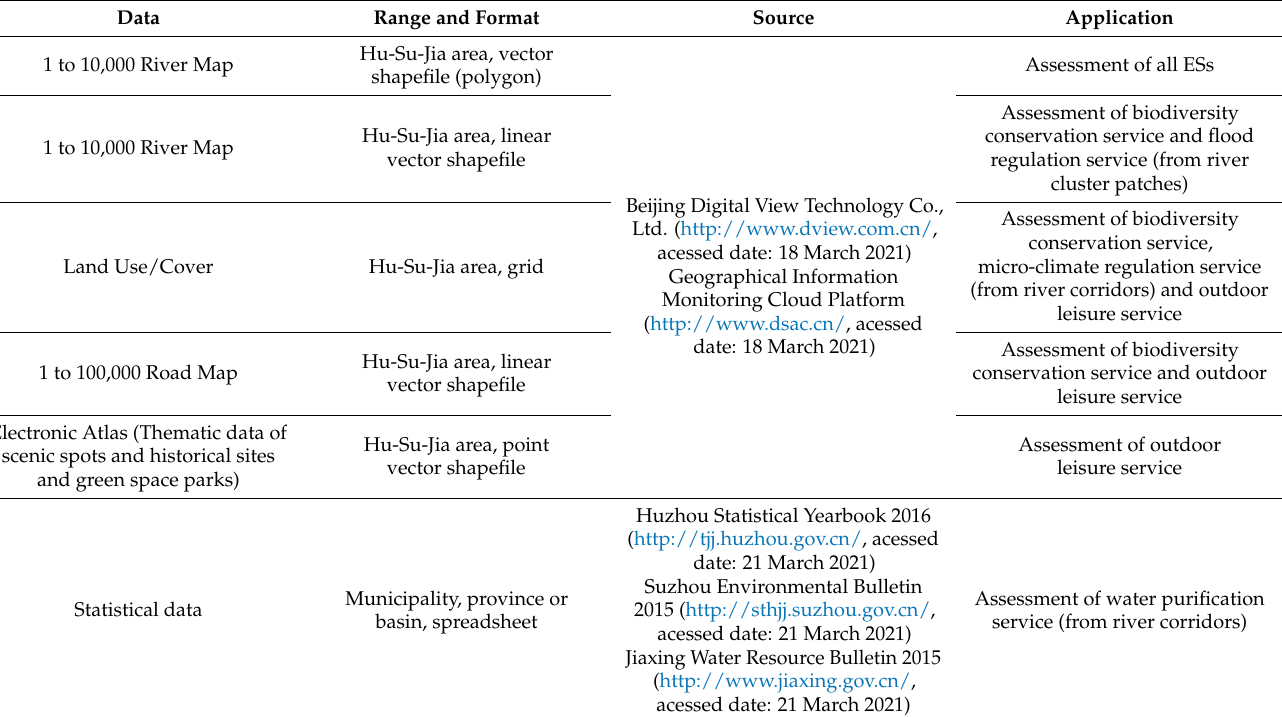
Table 2. Six datasets for the evaluation of the five ESs provided by linear water